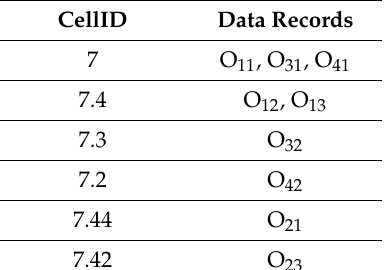
Table 1. CellIDs for data objects.